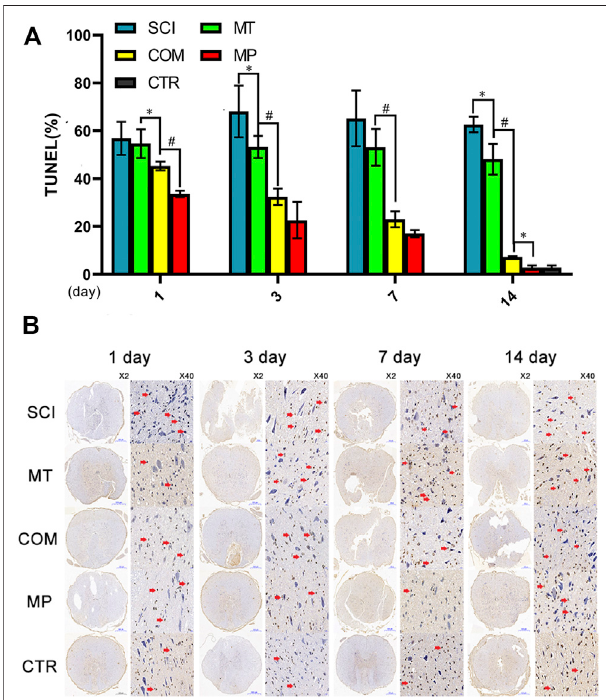
FIGURE2| Thenumberofapoptoticnervecellsamongdifferentgroups. (A) : The number of apoptotic nerve cells were quanti fi ed on the 1st, 3rd, 7th, and 14th day in neuronal samples taken from control rats (CTR, The average of the 4 sampling time points), rats with SCI (SCI), rats treated with melatonin (MT), methylprednisolone (MP), or a combination of MT with a low dose of MP (COM). (B) : Representative images of TUNEL stained nerve cells. The red arrow in the TUNEL image indicates nuclear shrinkage. Error bars represent the standard deviation. * p < 0.05, # p < 0.01 ( n (cid:1) 6).